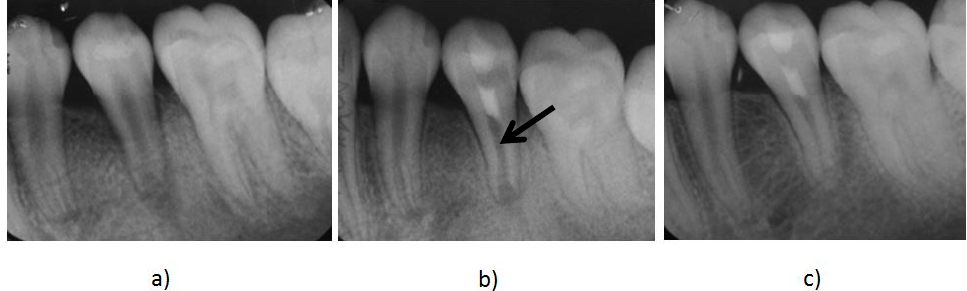
Figure 1. ( a ) A preoperative radiograph of an immature mandibular second premolar with pulp necrosis and apical periodontitis. ( b ) Immediate post-treatment radiograph of the tooth after the treatment with regenerative endodontic procedures (REPs). The mineral trioxide aggregate